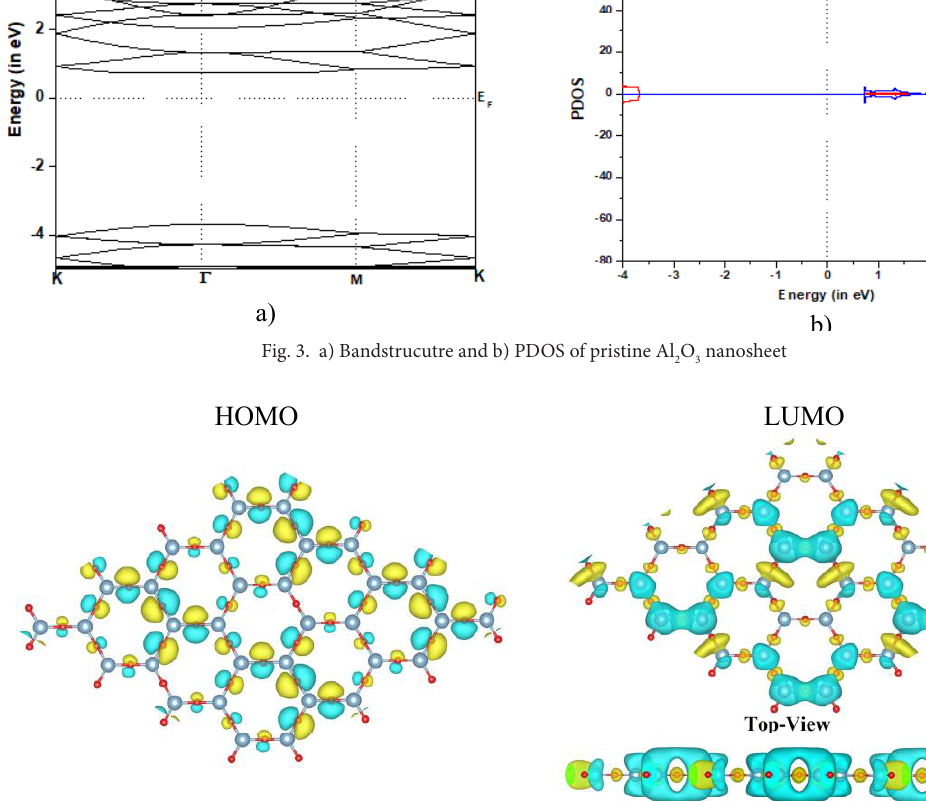
Fig. 4. Contour plot for HOMO and LUMO of the pristine Al